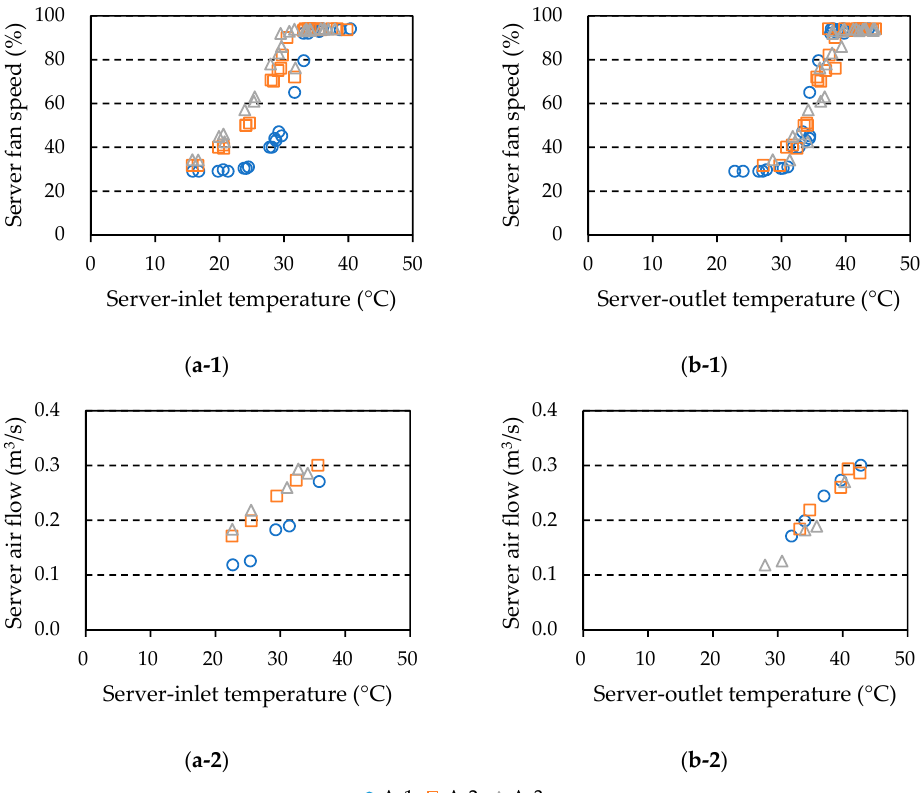
Figure 5. Relationships of server-fan speed and server airflow (experiment A) with ( a ) server-inlet temperature and ( b ) server-outlet temperature for each CPU usage rate at server ambient temperature.